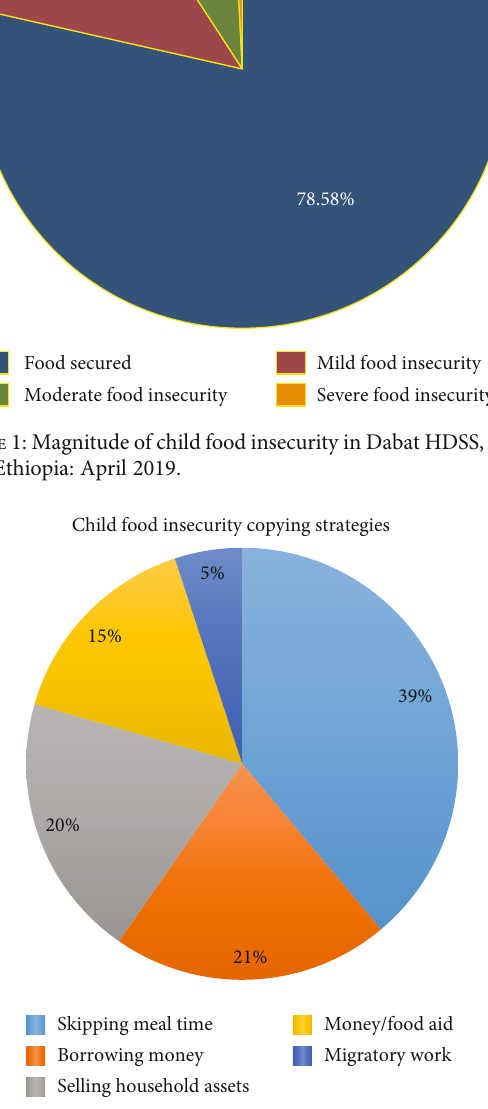
Figure 2: Child food insecurity copying strategies in Dabat HDSS, North West Ethiopia: April